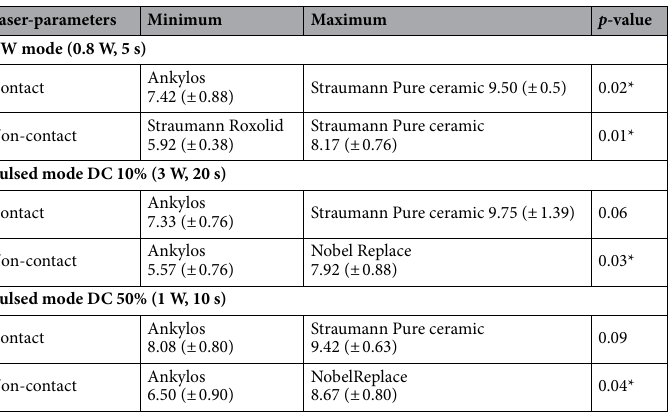
Table 2. Statistical analysis of the maximal and minimal thermal effects (∆T [°C], mean ± SD) of 445 nm laser irradiation on cervical interface temperature in five dental implant systems. *Statistical significance on the 5%